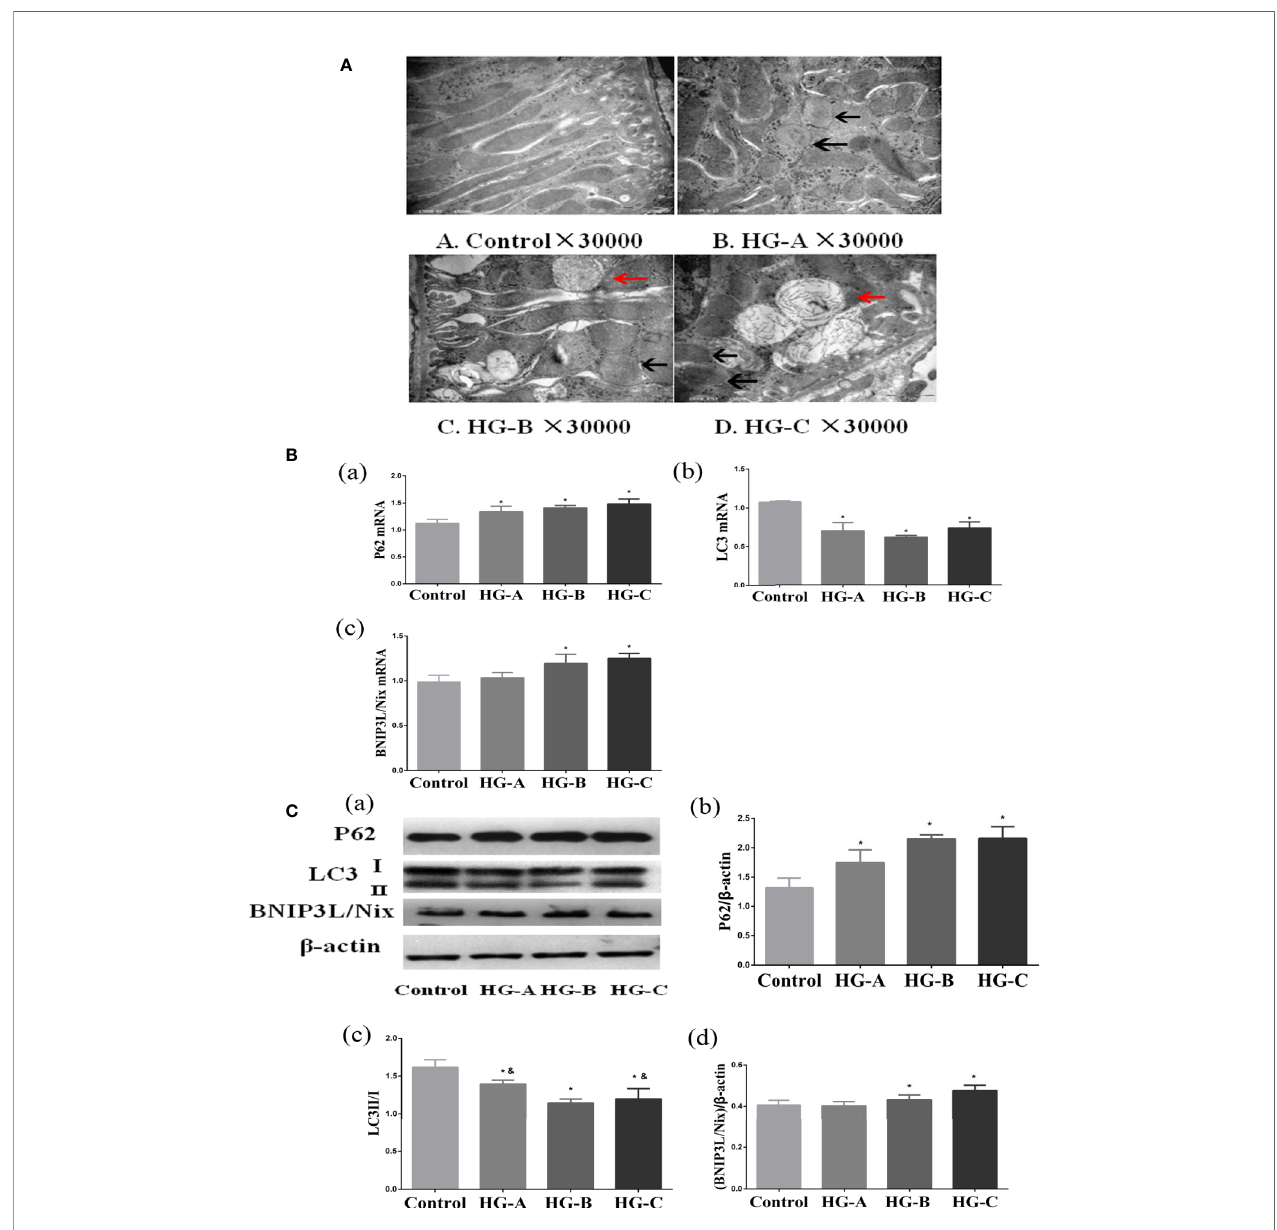
FIGURE 4 | Mitophagy was inhibited in the kidney under acute hyperglycemic state. N = 10 in each group. (A) Swelling of mitochondria, mitochondrial fragmentation, irregular arrangement and irrecognizable mitochondrial crista observed using transmission electron microscope (black arrow). Abnormal autophagosome accumulation under transmission electron microscope (red arrow). (B, C) Alterations of mitophagy related markers in different groups. Values are presented as means ± SD in each group. * P < 0.05 vs. Control; & P < 0.05 vs. HG-B. Control, control group; HG-A, hyperglycemia group A; HG-B, hyperglycemia group B; HG-C, hyperglycemia group